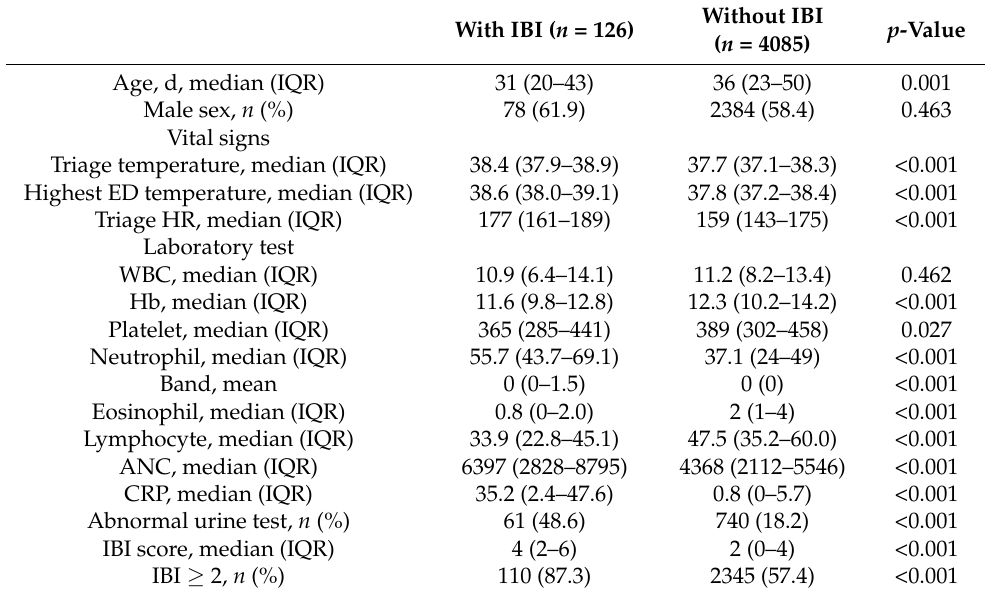
Table 3. Demographic and clinical characteristic comparison between patients with and without invasive bacterial infections.